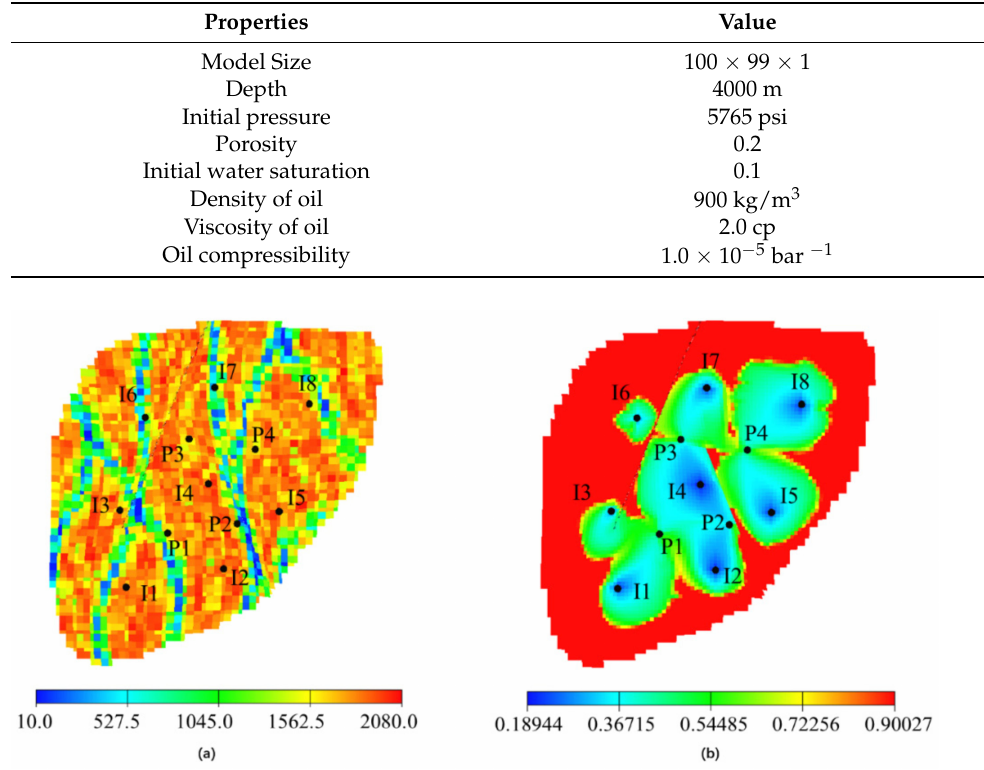
Figure 13. The permeability and oil saturation distribution of Egg reservoir case: ( a ) Permeability distribution; ( b ) oil saturation